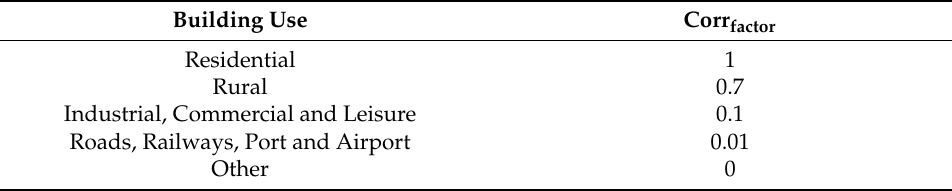
Table 5. Correction factors per building